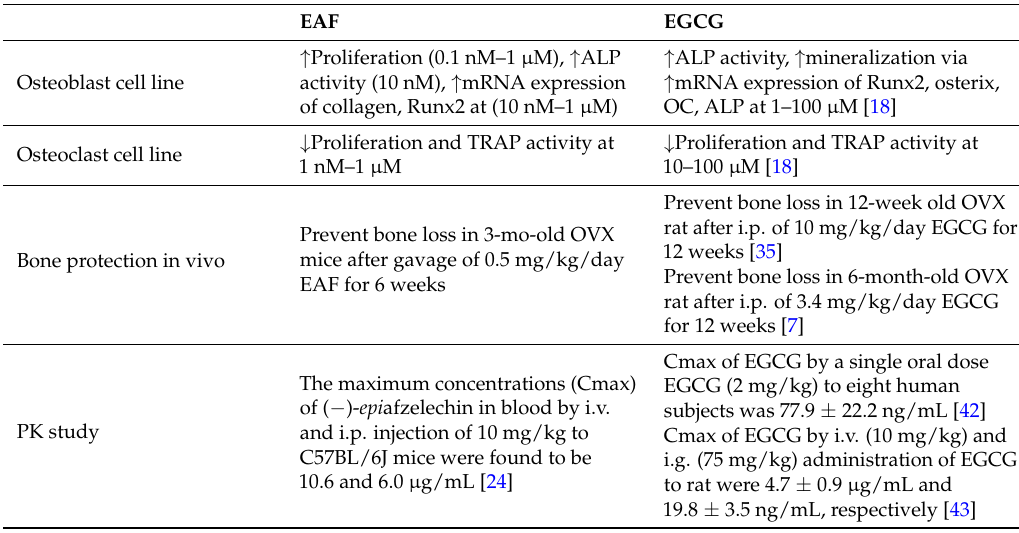
Table 3. Comparison of the actions of EAF and epi galloacatechin-3-gallate (EGCG). EAF EGCG Osteoblast cell